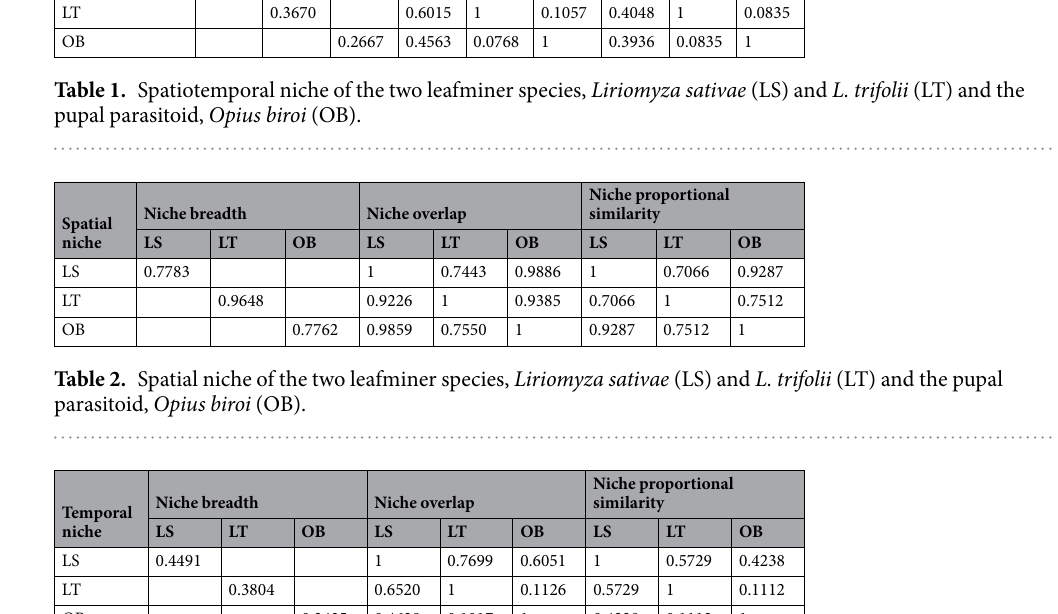
Spatiotemporal niche